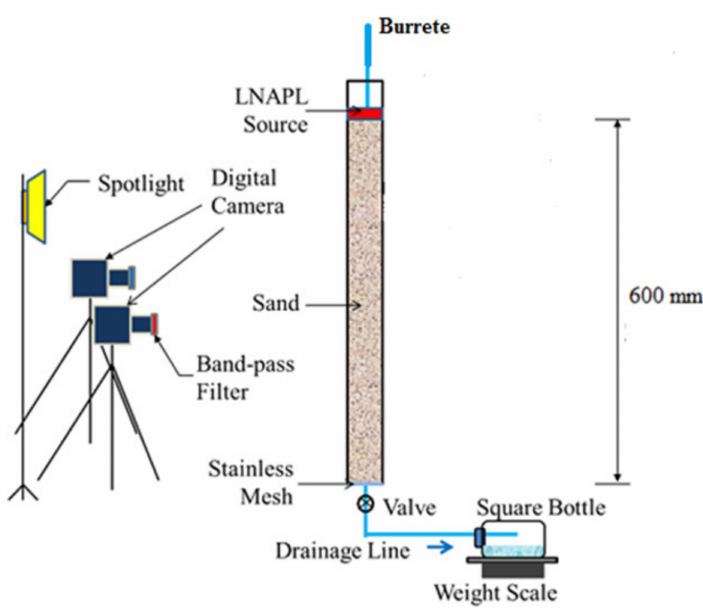
Figure 1. Experimental